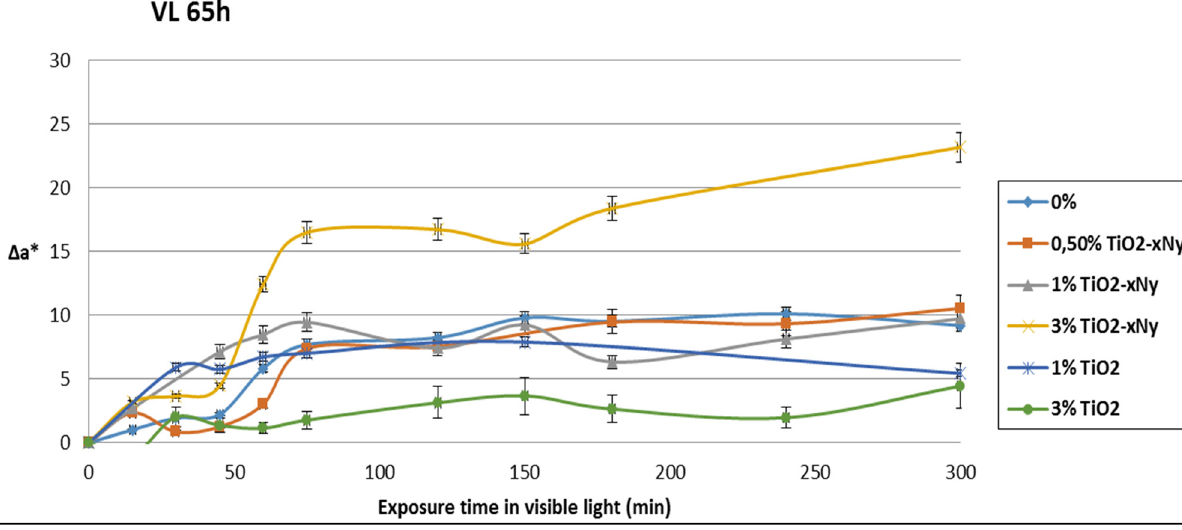
Figure 5. Change in Δ a * during 5 h exposure to visible light with different addition